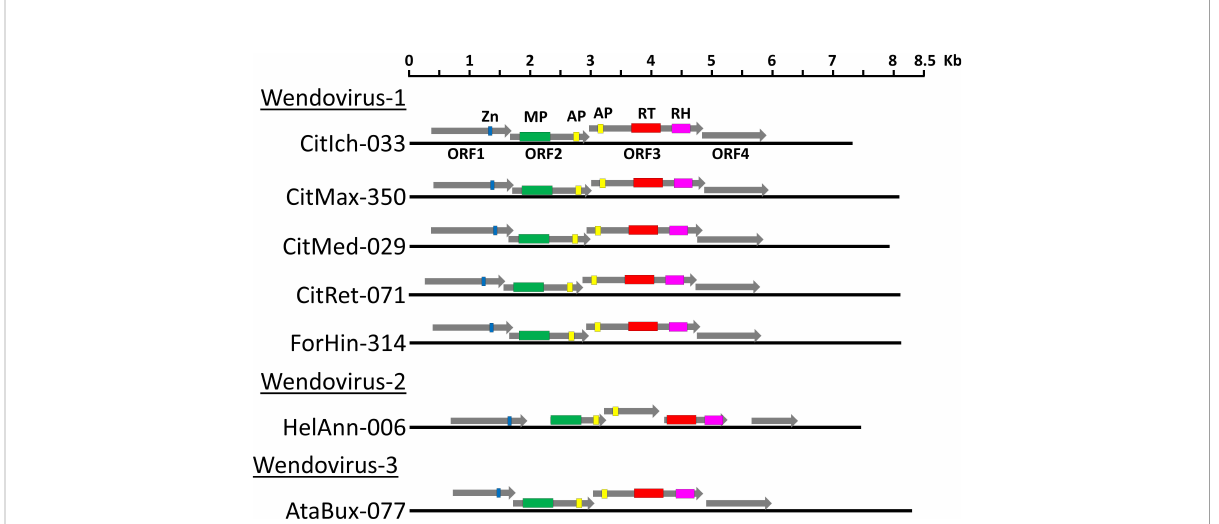
FIGURE 3 Schematic representation of wendovirus endogenous pararetrovirus. A scaled linear view of the genome organization of Wendovirus . The name of the sequences is the same as in Supplementary Data 4. Grey arrows mark open reading frames and colored regions within ORFs are conserved protein domains: blue, zinc fi nger typically present in the coat proteins; green, Movement Protein; yellow, Aspartic Proteinase; red, Reverse Transcriptase; pink,